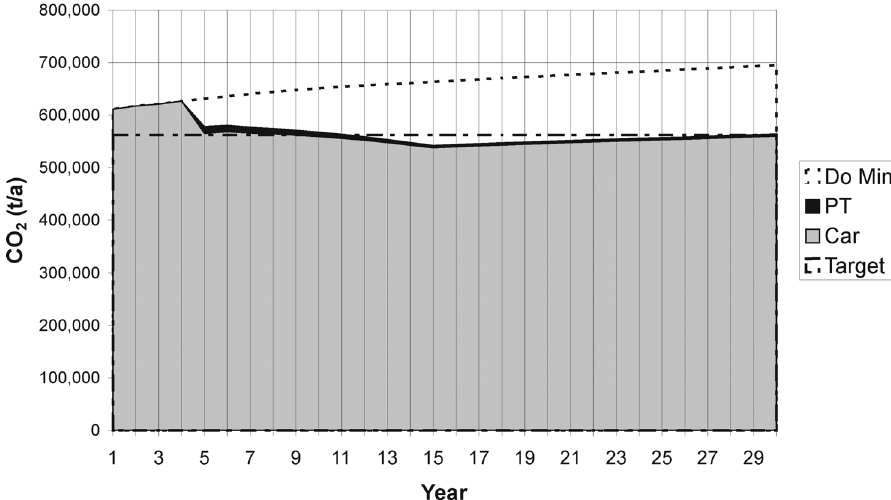
Figure 11: Development CO